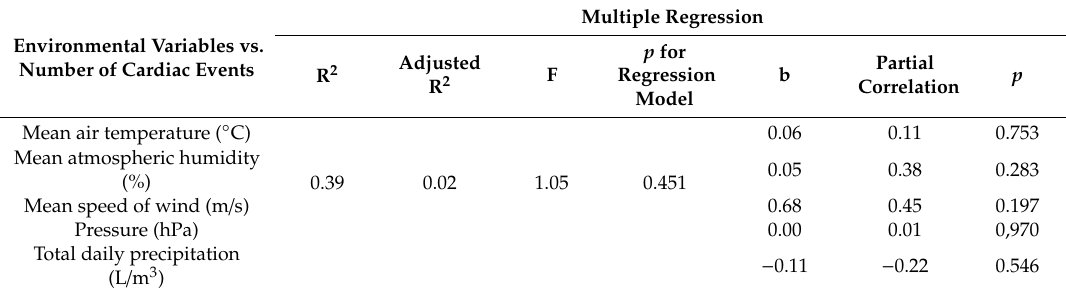
Table 8. Assessment of the number of cardiac events / number of admissions relative to the environmental variables from 1 to 14 December.